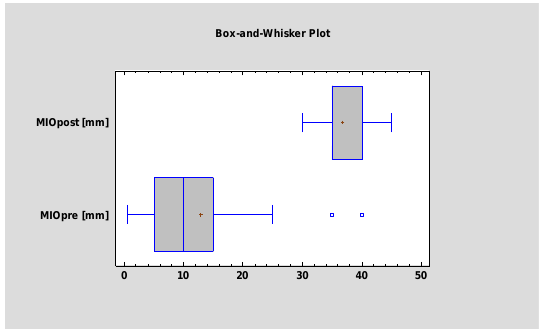
Figure 6. Student ’s t -test evaluating statistical differences in MIO (maximal interincisal opening) before and after the surgery. Statistical significance was established at p < 0.005. The average postoperative MIO was 38.75 mm (mean improvement of +13.75 mm), which confirms the beneficial effect of the surgery on mouth opening (Figure 7).